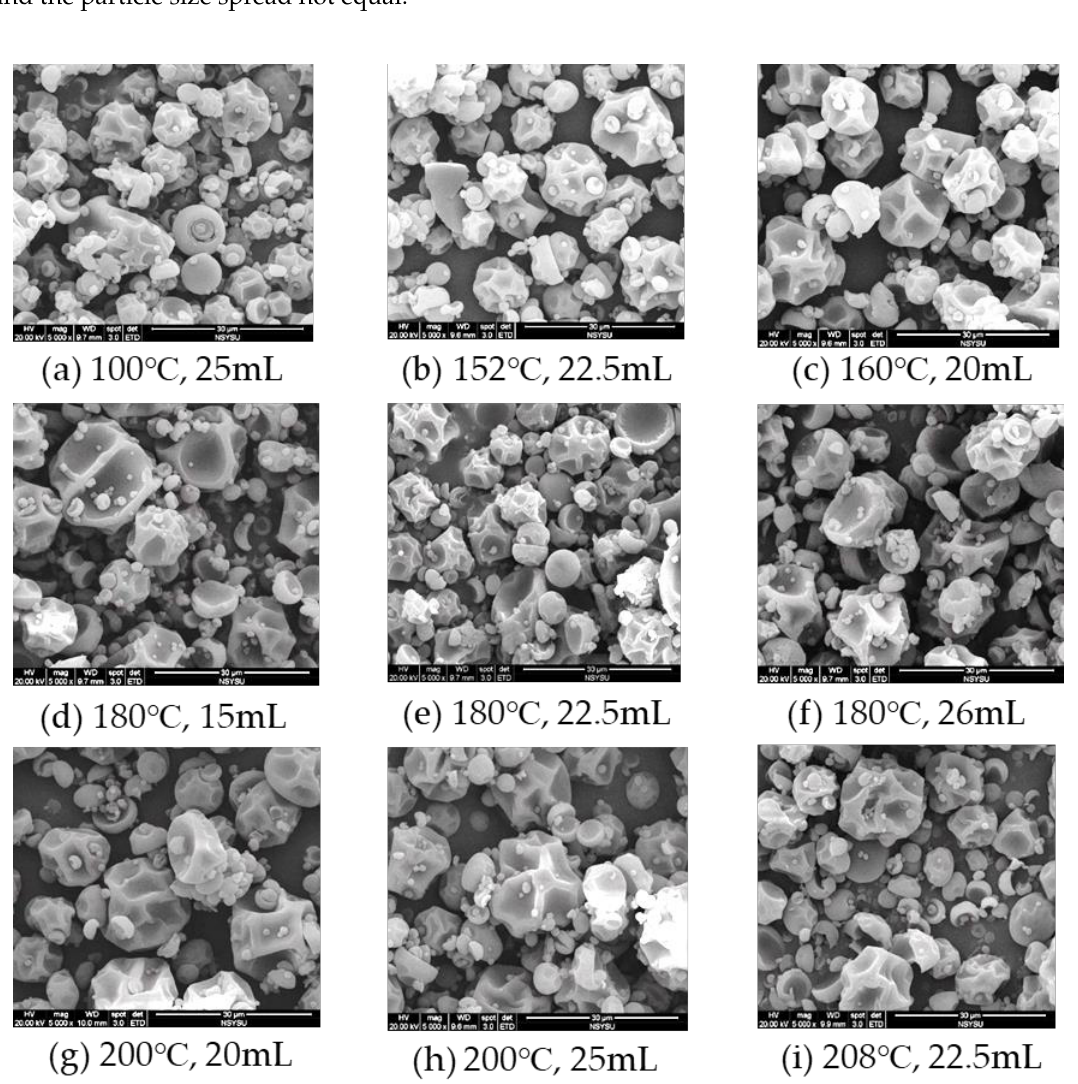
Figure 4. Scanning Electron Microscopy (SEM) analysis of powder with di ff erent conditions. ( a ) 100 °C, 25 mL, ( b ) 152 °C, 22.5 mL, ( c ) 160 °C, 20 mL, ( d ) 180 °C, 15 mL, ( e ) 180 °C, 22.5 mL, ( f ) 180 °C, 26 mL, ( g ) 200 °C, 20 mL, ( h ) 200 °C, 25 mL, ( i ) 208 °C, 22.5 mL.